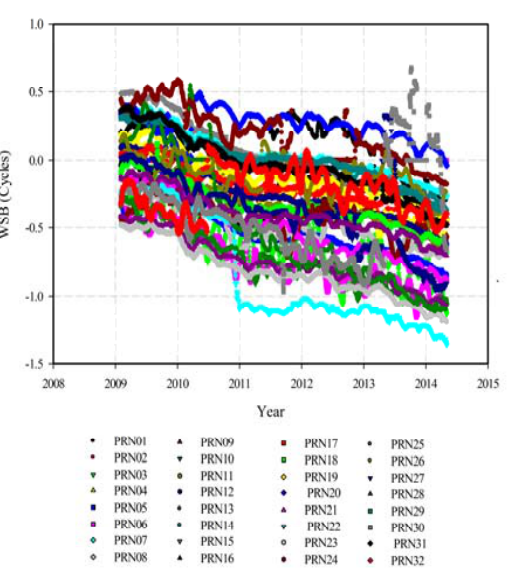
Figure 1. CNES/CLS Daily WSB Since 2009